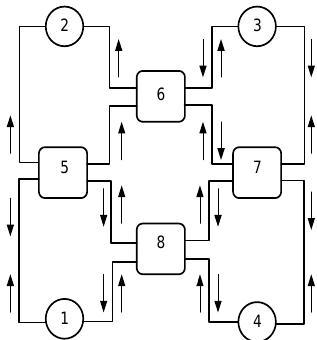
Figure 4. Frame distribution under the standard HSR protocol as a result of sending a unicast frame from Node 1 to Node